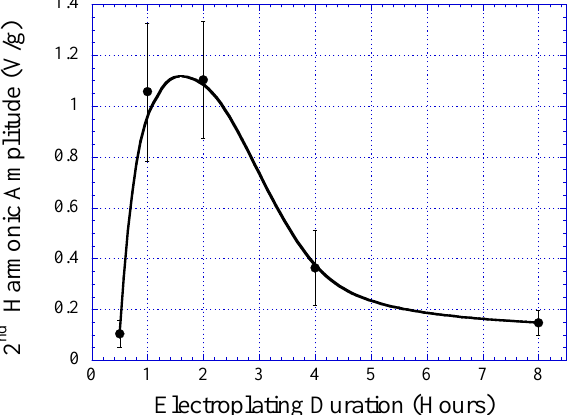
Figure 5. The maximum amplitude of the 2nd-order harmonic fields exhibited by electroplated nickel-iron alloys plated for 0.5, 1, 2, 4, and 8 h normalized to the sample mass.